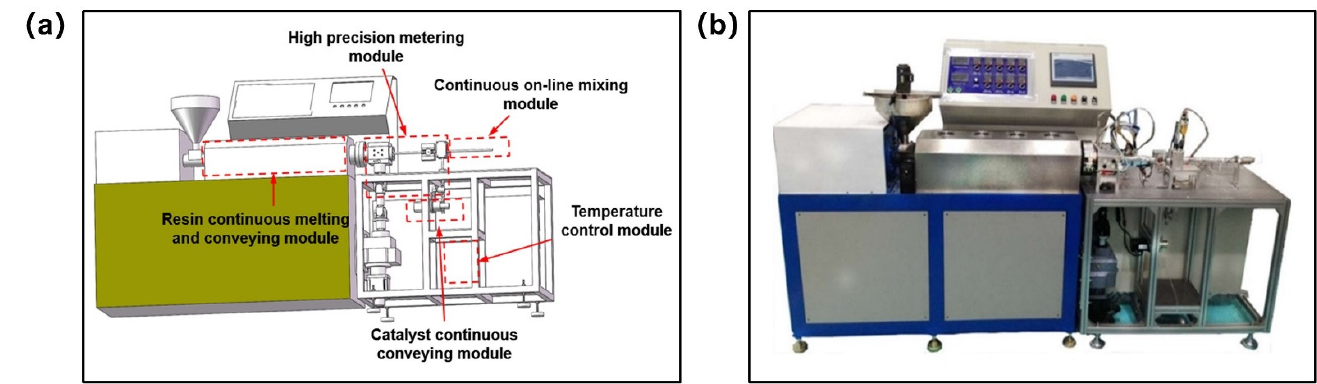
Table 2. Main technical parameters of in situ polymerization injection molding equipment.